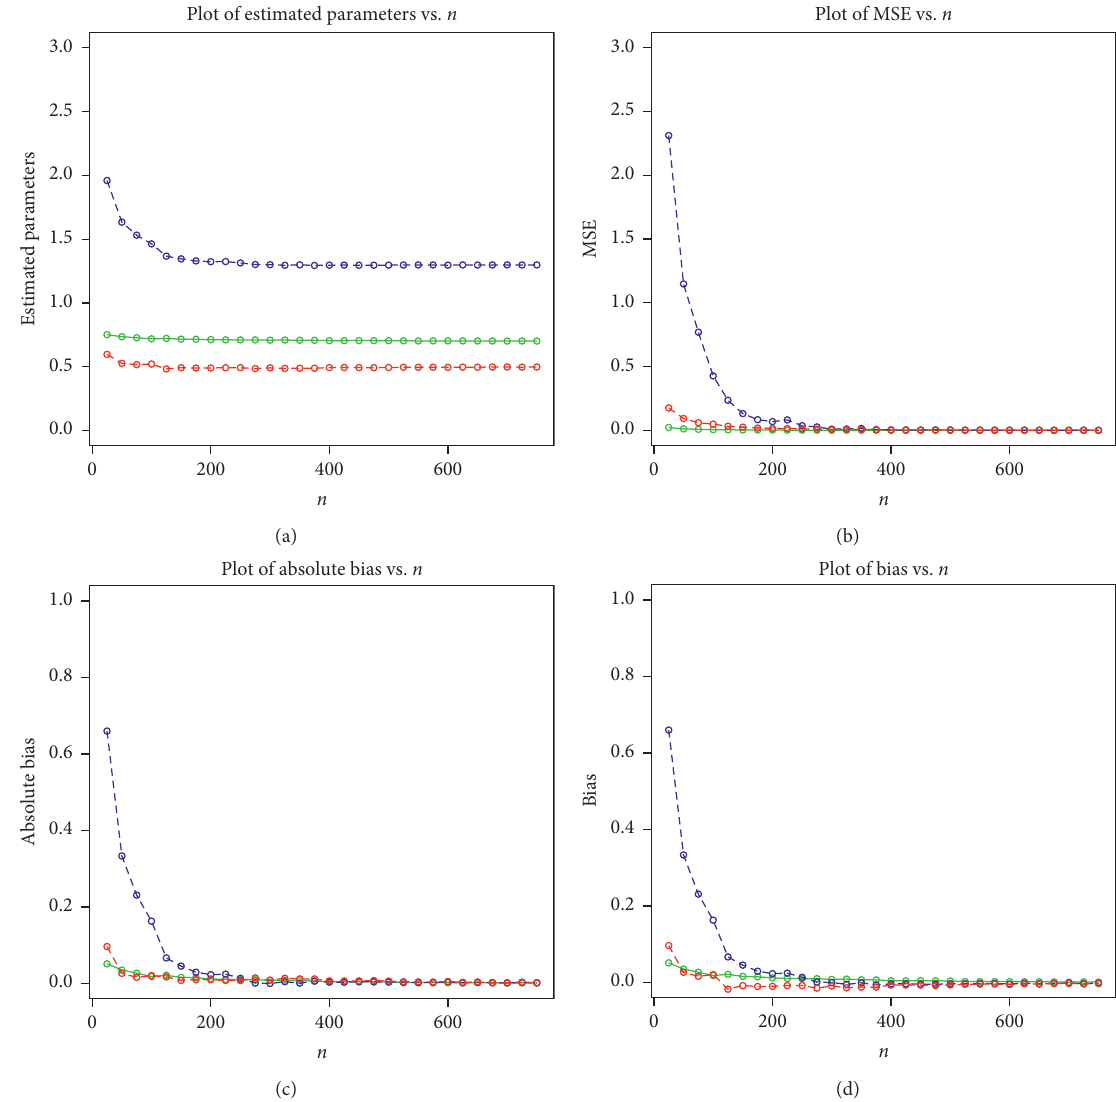
Figure 10: Plots of MLEs, MSEs, biases, and absolute biases for α � 0 . 7 ( green − line ) , c � 0 . 5 ( red − line ) , and σ � 1 . 3 ( blue − line ) . Plot of estimated parameters vs.